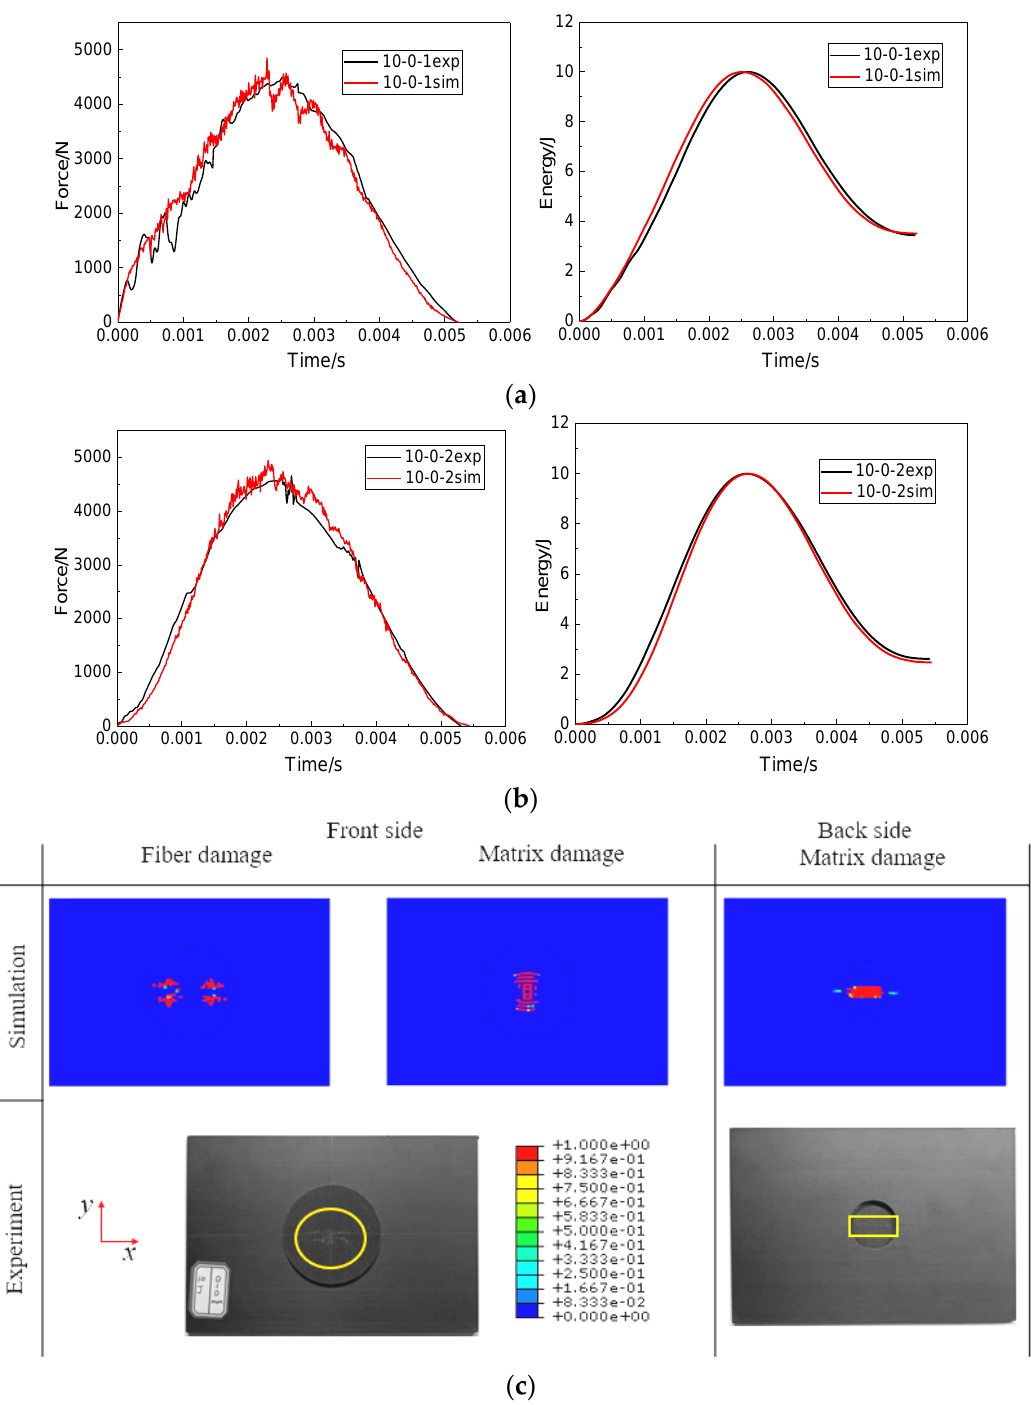
Figure 11. Comparisons of force–time curves and impact energy curves between the simulation and experiment results at an impact distance of 0 mm: ( a ) the first impact, ( b ) the second impact and ( c ) comparisons of the damage profiles after the second